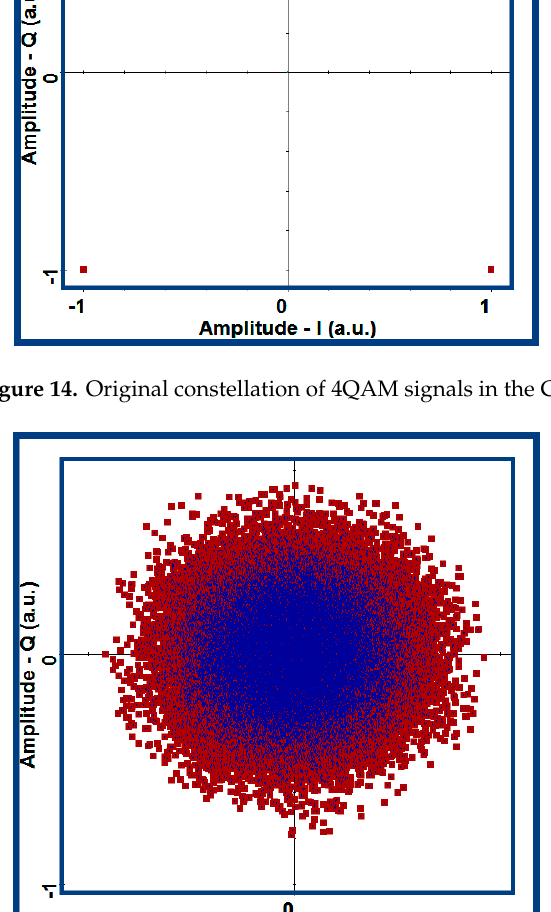
Figure 15. Original constellation of 4QAM-OFDM signals in the CS.